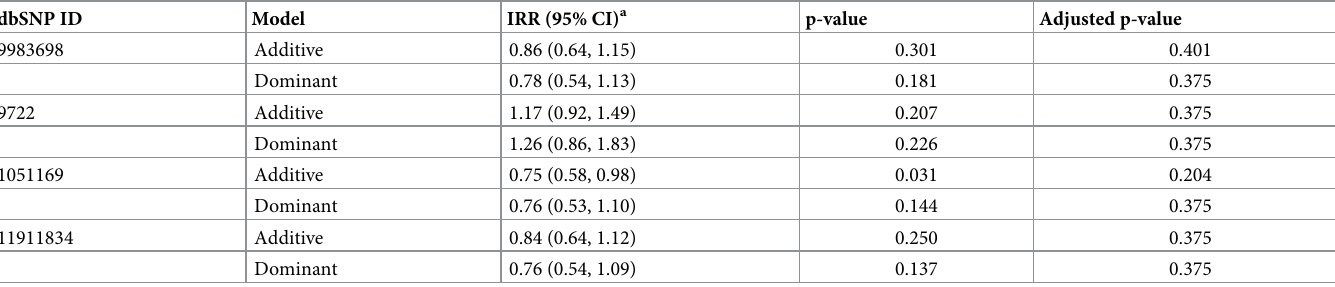
Table 5. Single SNP regression analysis of utilization.